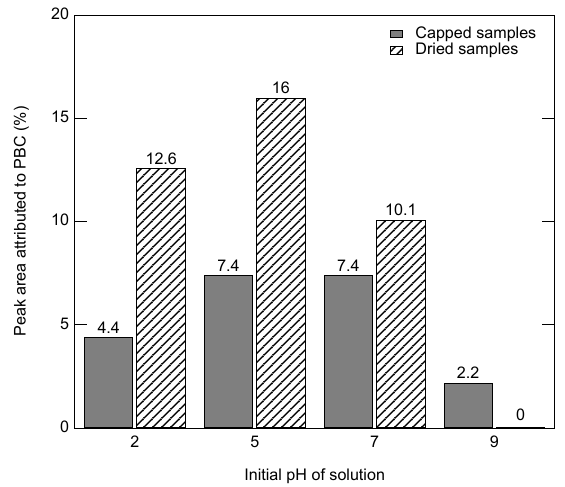
Figure 7. Estimated contribution of PBC to the total ion signal cal- culated as the sum of the “percent peak areas” for masses m/z 109, 162, 181, 235, 253, and 289. Many of these masses were below the detection limit in one or more